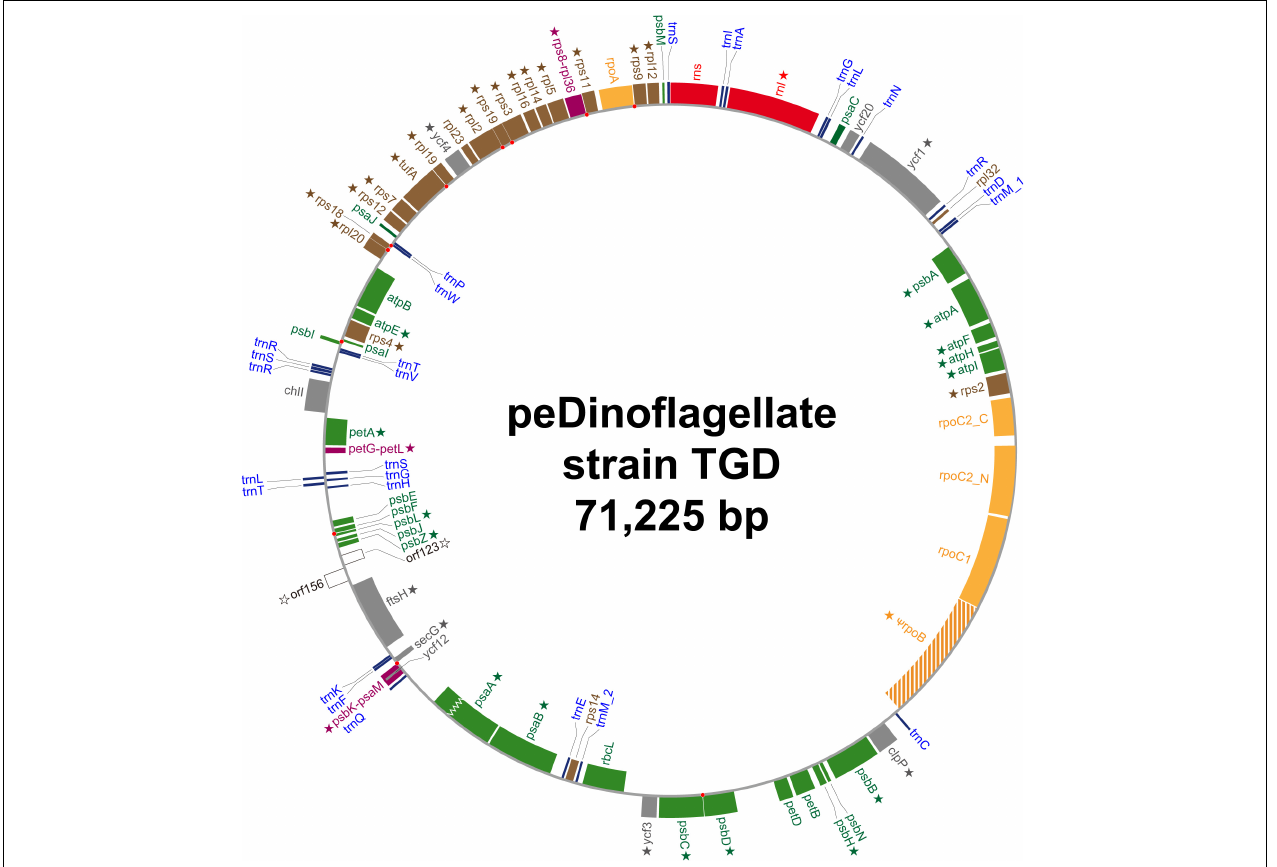
FIGURE 2 | Circular map of the plastid genome of the peDinoflagellate strain TGD. Open reading frames (ORFs) encoding proteins involved in photosynthesis, translation, transcription, and other function are colored in green, brown, orange, and gray, respectively. Functionally unassigned ORFs are shown in white. Fused ORFs are highlighted in purple. rpoB in the TGD genome is considered as a pseudogene. The ORF for PsaA in the TGD genome was found to be interrupted by a frameshift (marked by a zigzag line). Ribosomal RNA genes and transfer RNA genes are colored in red and blue, respectively. The ORFs/genes, of which transcripts received RNA editing, are marked by stars. Red dots indicate the overlap of two neighboring